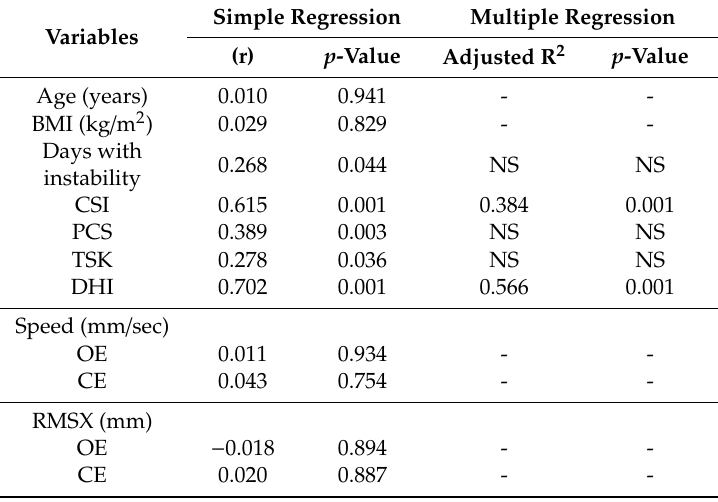
Table 3. Simple and multiple linear regression model to predict